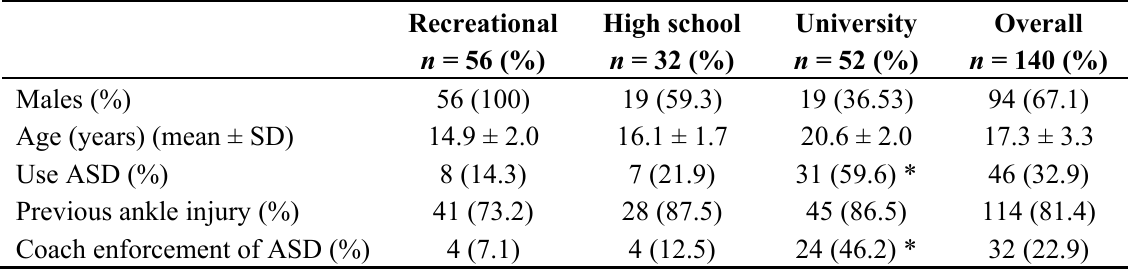
Table 2. Demographic characteristics of recreational, high school, and university basketball players.